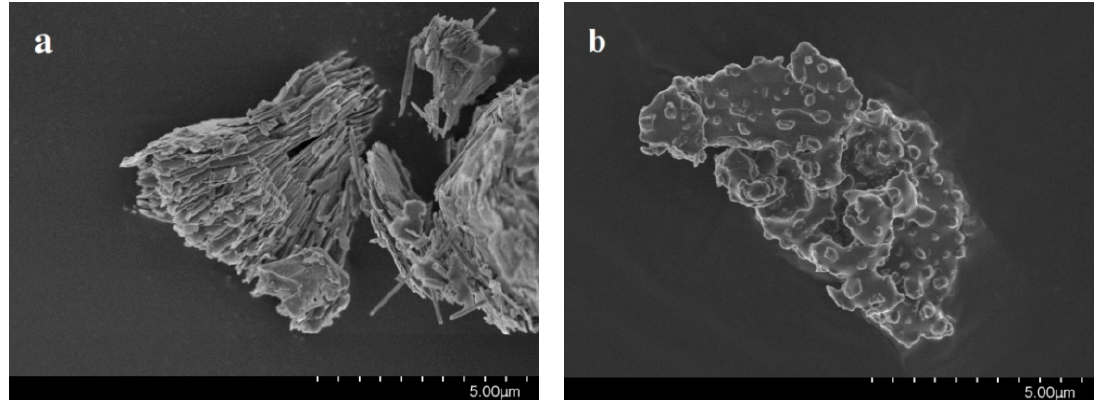
Figure 3. Scanning Electron Microscopy images for ( a ) kaolin and ( b ) metakaolin.